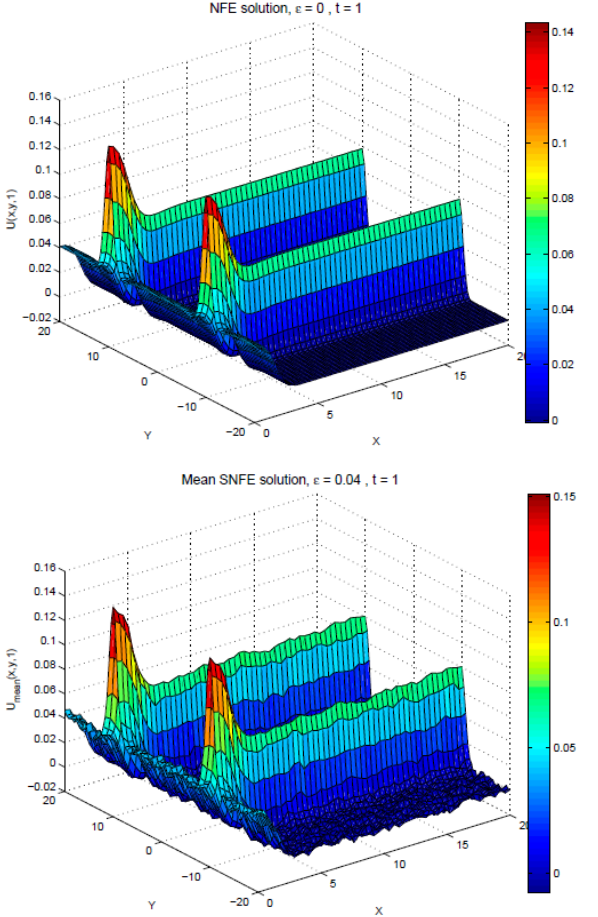
Figure 11. Snapshots of the solution of Example 3 at time t = 1: up- E = 0; down, left-hand side -E = 0.04; down, right- hand side- E =